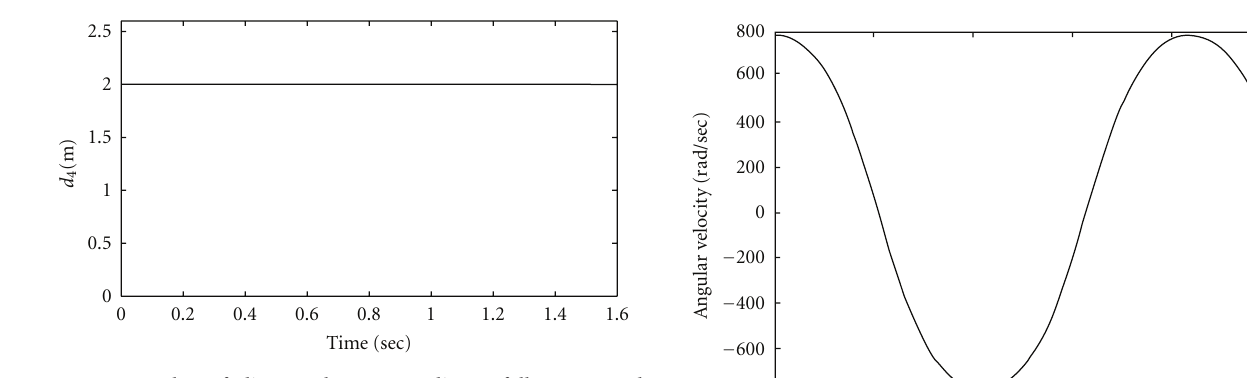
Figure 10: Plot of distance between ordinary follower 1 and ordinary follower 2 versus time.